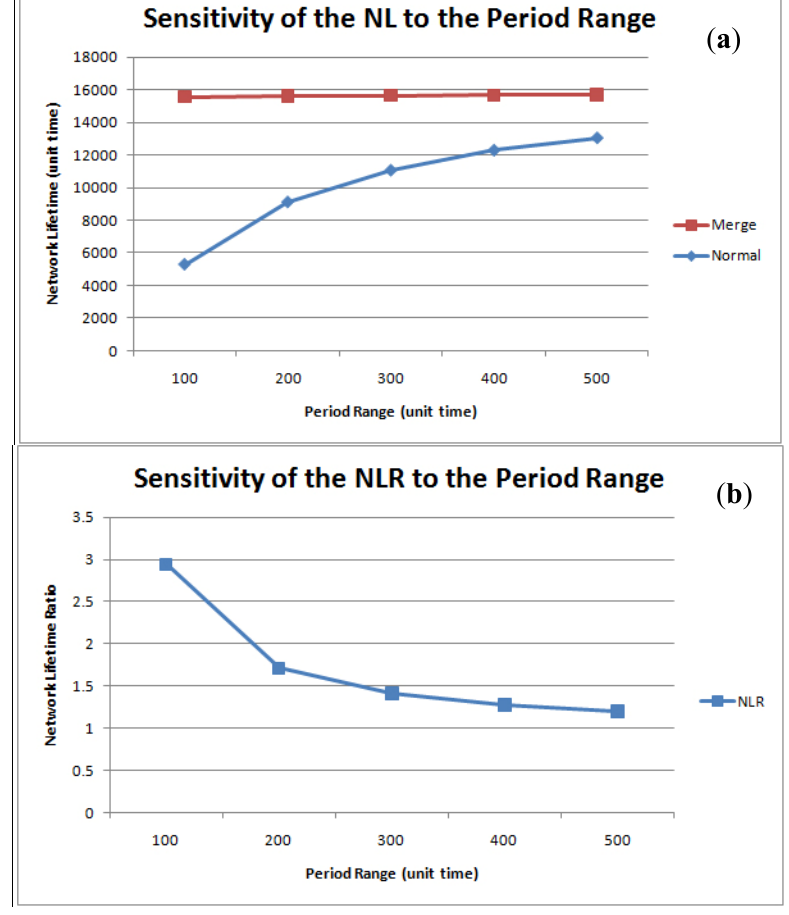
Figure 17. Sensitivity of the (a) Network Lifetime and (b) NLR to the period